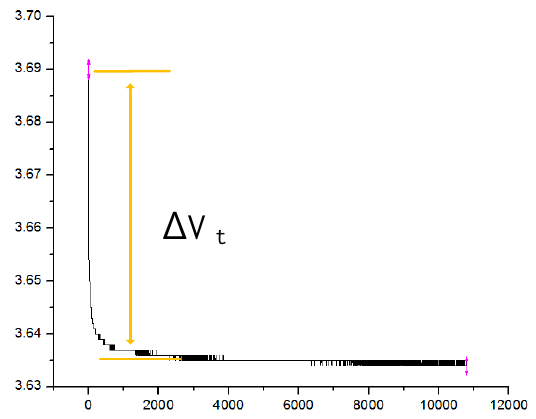
Figure 4. Transient response of a lithium-ion battery.